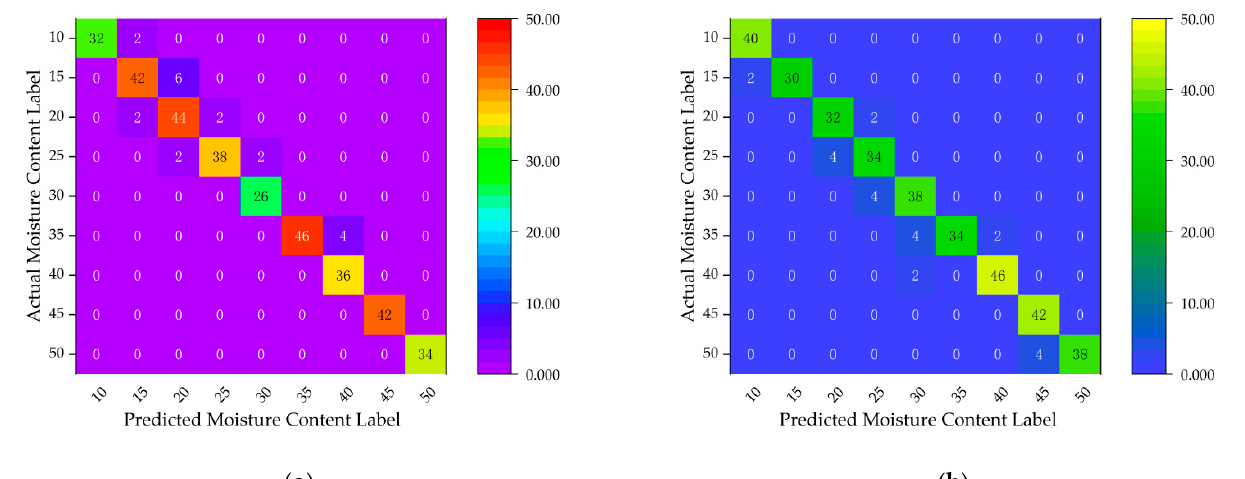
Figure 21. Comparison of each evaluation metric of GSCV-LGB algorithm, GSCV-RF algorithm and GSCV-DT algorithm. ( a ) Precision comparison chart; ( b ) comparison chart of recall rate; ( c ) F1-score comparison chart; ( d ) MCC comparison chart; ( e ) ROC curve comparison chart; ( f ) confusion matrix of GSCV-LGB algorithm; ( g ) confusion matrix of GSCV-RF algorithm; ( h ) confusion matrix of GSCV-LGB algorithm.